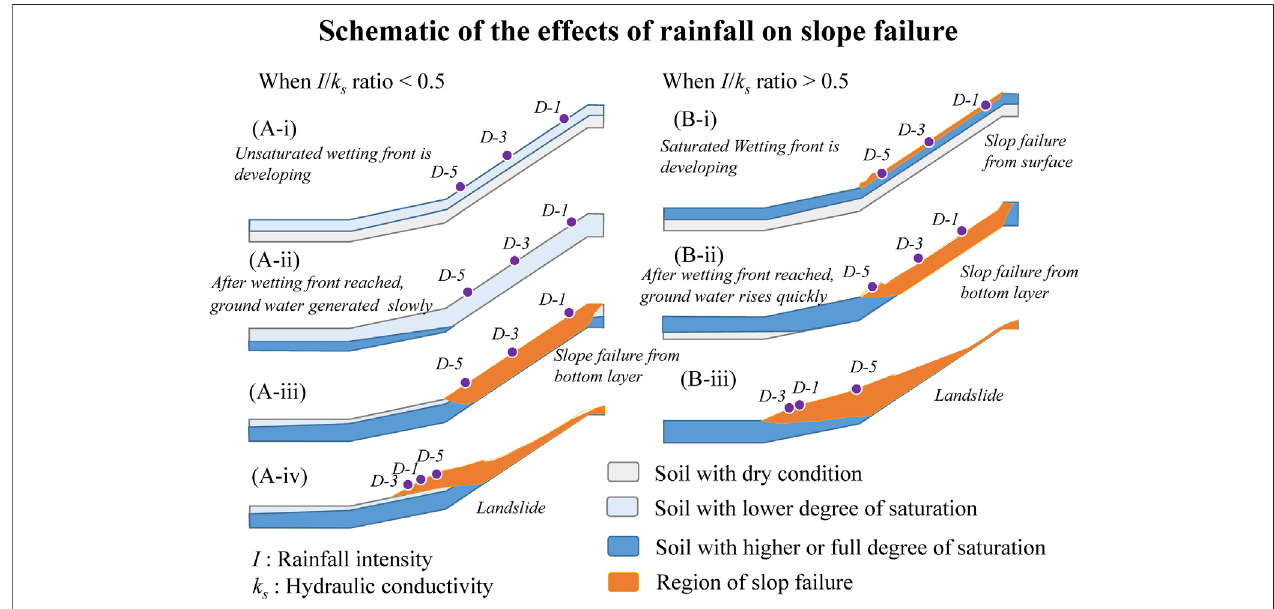
FIGURE 9 | Schematic of the effects of rainfall on slope